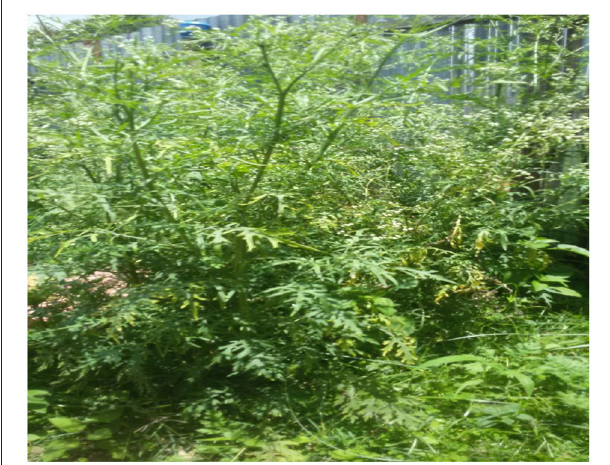
FIGURE 1 | The Parthenium weed (Photo taken from Uffa Kebele, Kaffa zone, by Tesfaye G., May 2018GC.).